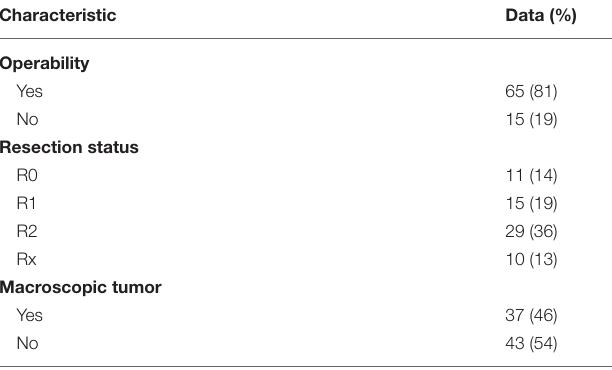
TABLE 2 | Treatment characteristics (n = 80).